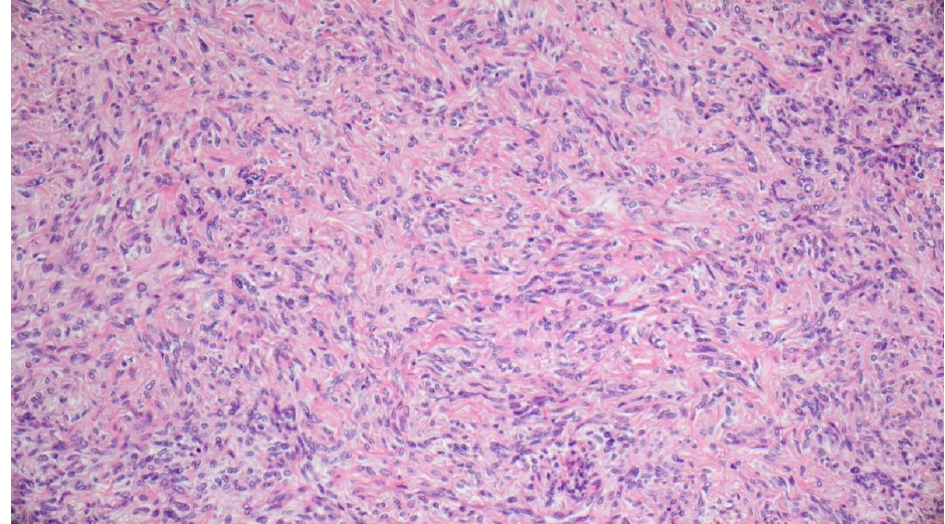
Figure 4. Postembolization angiography. A control DSA with injection in the right external carotid artery (AP-projection) showing a good angiographic result of the tumor embolization, with con- trast filling of arterial branches to the external ear (arrows).